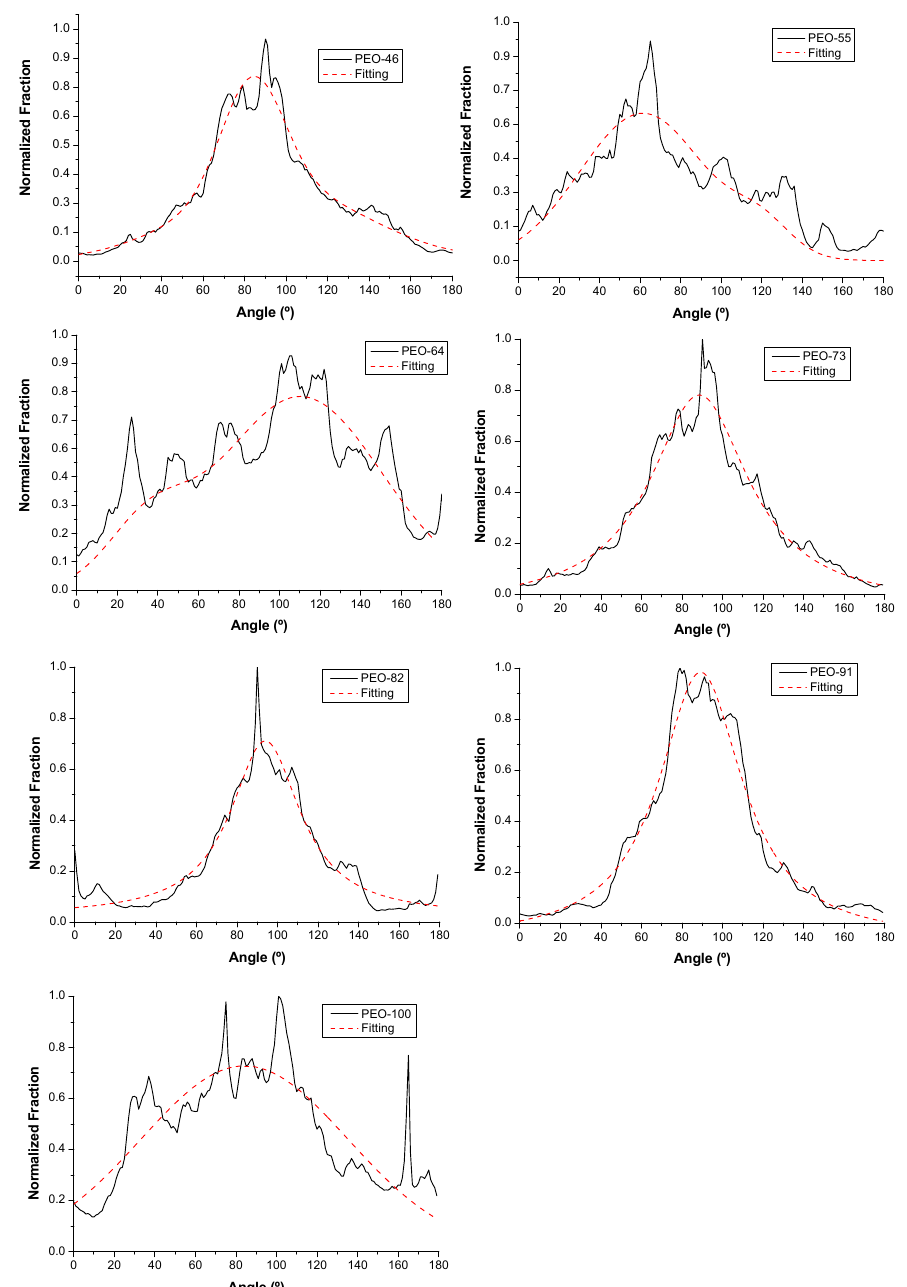
Figure 6. Normalized orientation distributions of blow spun PEO fibers at different compositions Chl:Ac.